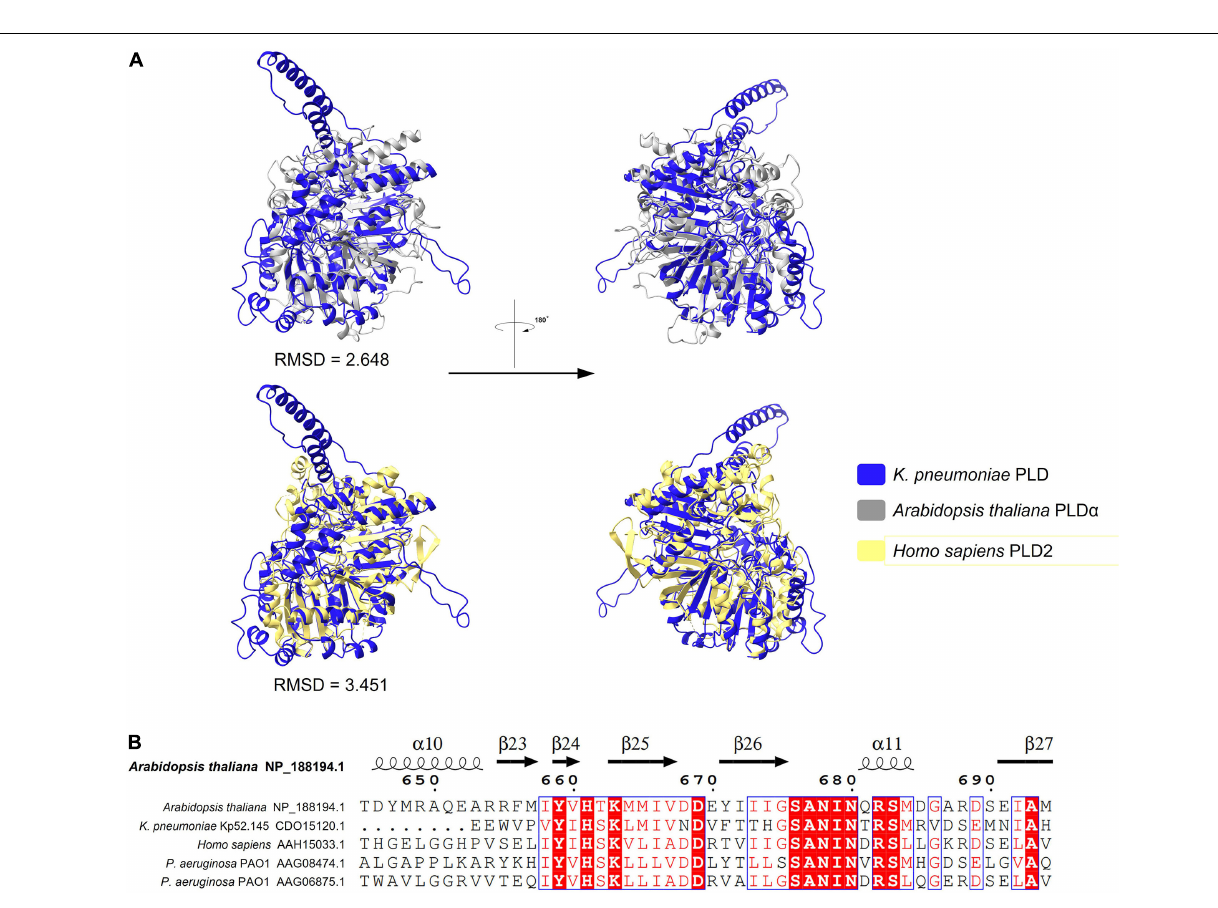
Frontiers in Microbiology |